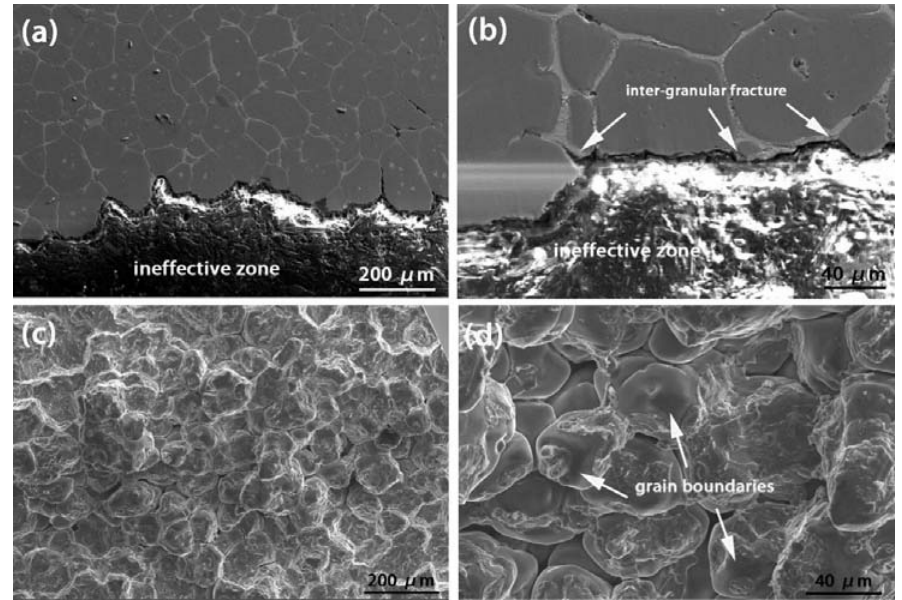
Figure 11. SEM images of the fracture micrographs of the room temperature tensile samples after reheating at 620 °C for 25 min, ( a , b ) fracture profiles; ( c , d ) fracture surfaces.